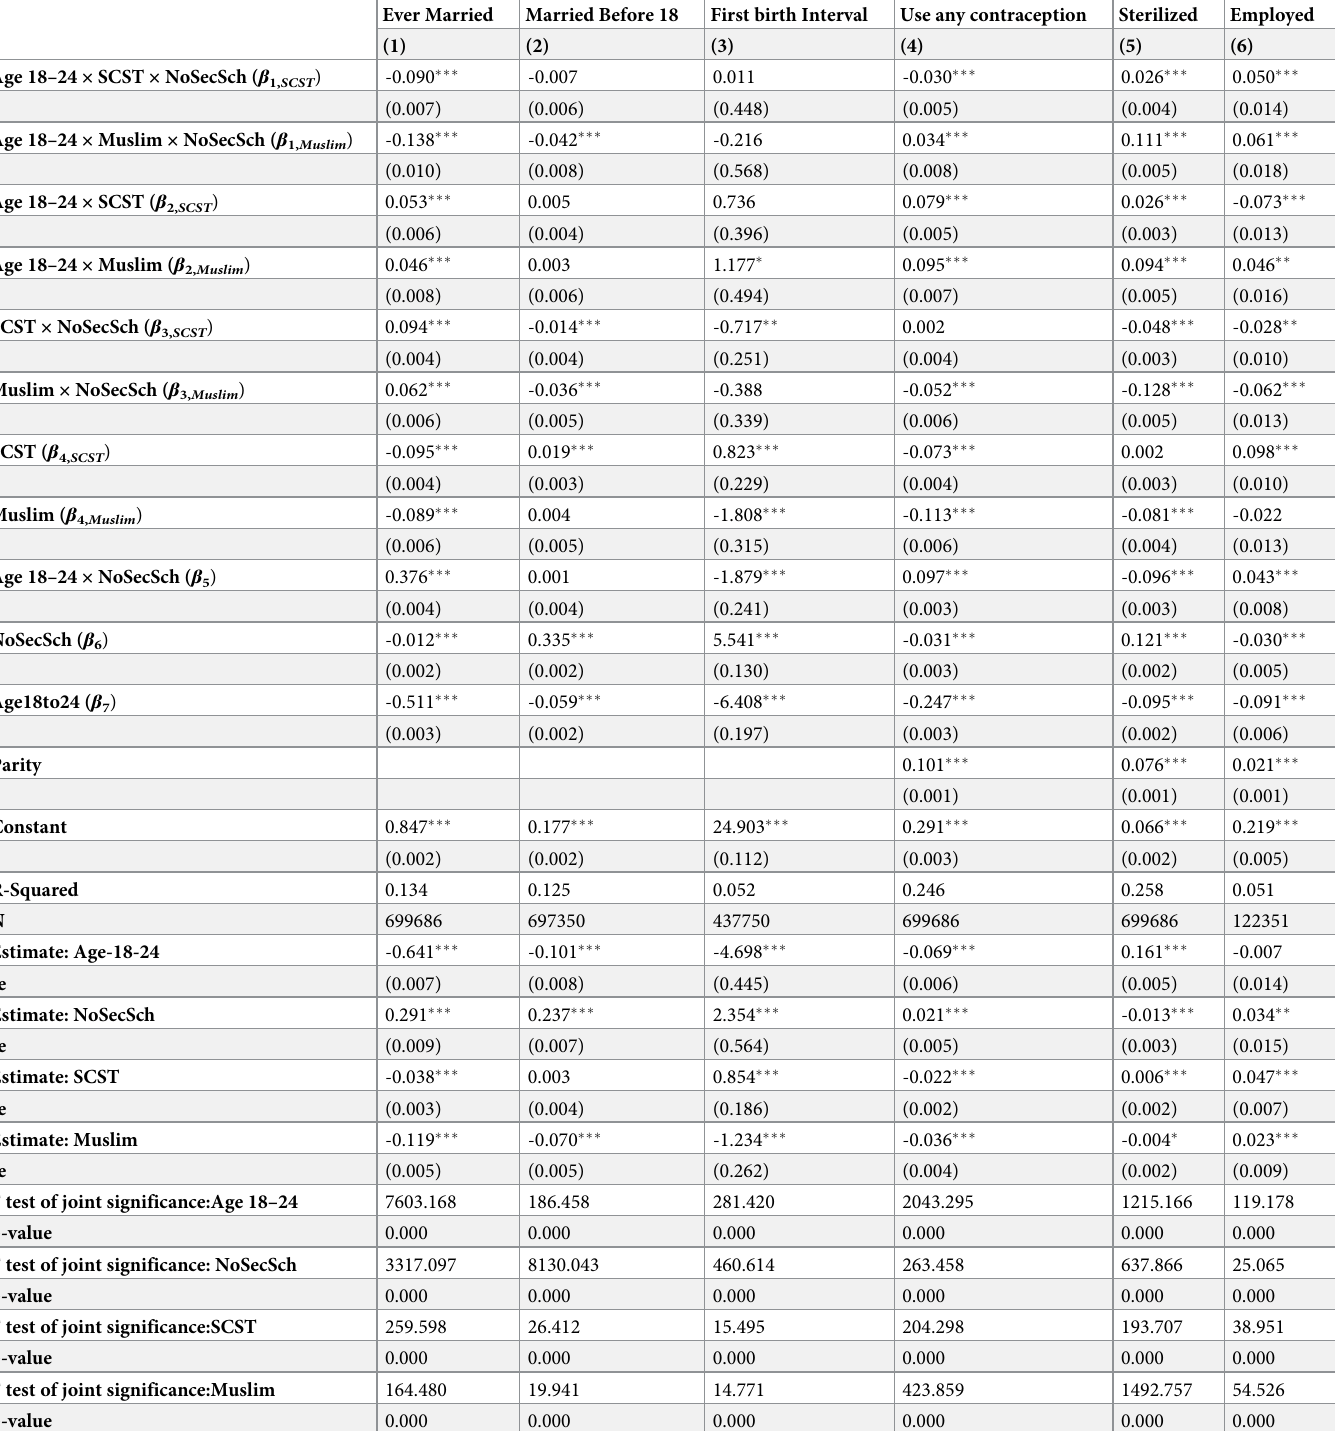
Table 4. Determinants of regression results from NFHS-4. Ever Married Married Before 18 First birth